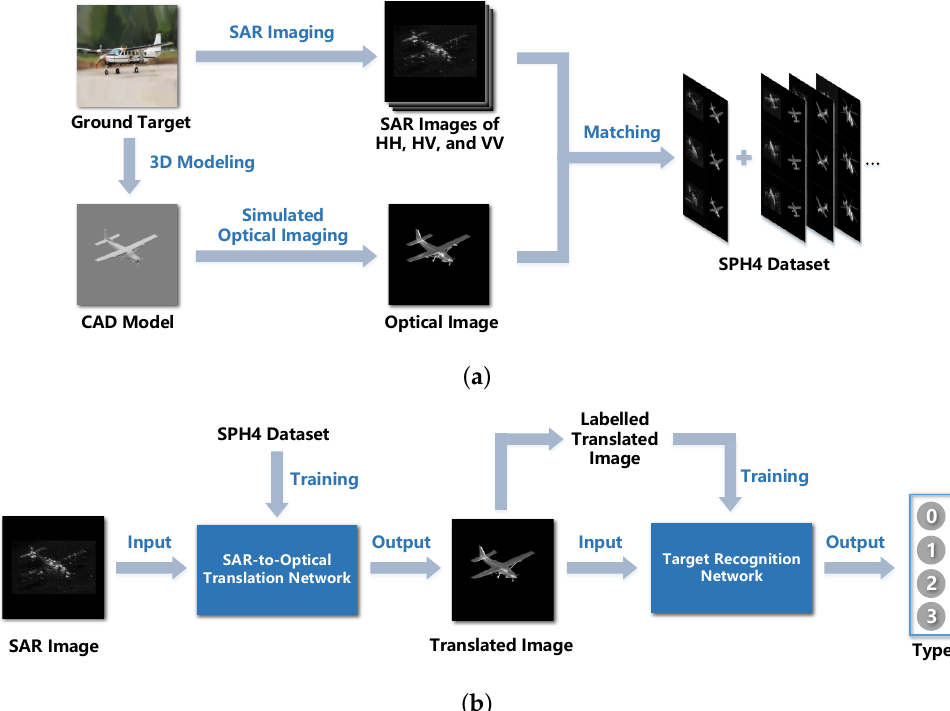
Figure 1. Entire recognition system. ( a ) Creation of the SPH4 dataset; ( b ) Training of the translation network and recognition